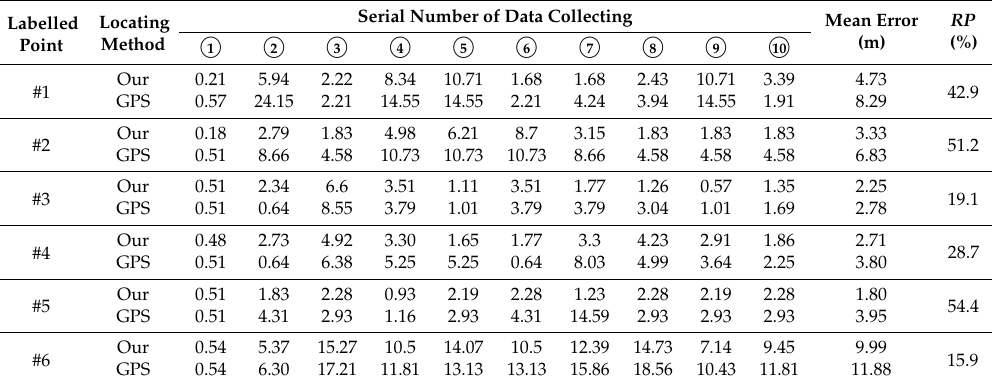
Table 9. Positioning errors (in meters) of the proposed approach (abbreviated as “Our” in the table) and GPS in outdoor environments.